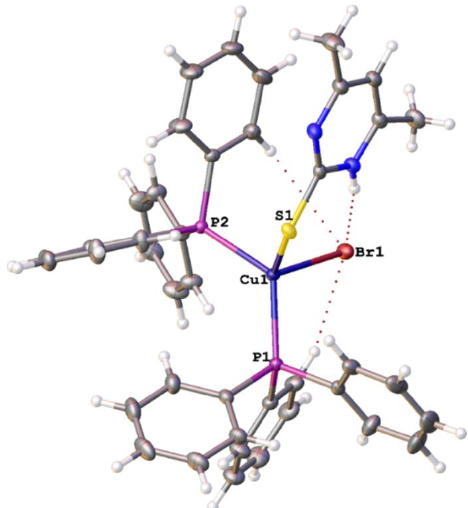
Figure 1. Molecular structure of the [Cu(PPh 3 ) 2 (C 6 H 8 N 2 S)]Br complex. Thermal ellipsoids are drawn at a 50% probability level and the H-atoms are drawn as spheres of arbitrary radii. The intramolecular H-bonds are indicated by red-dotted lines.